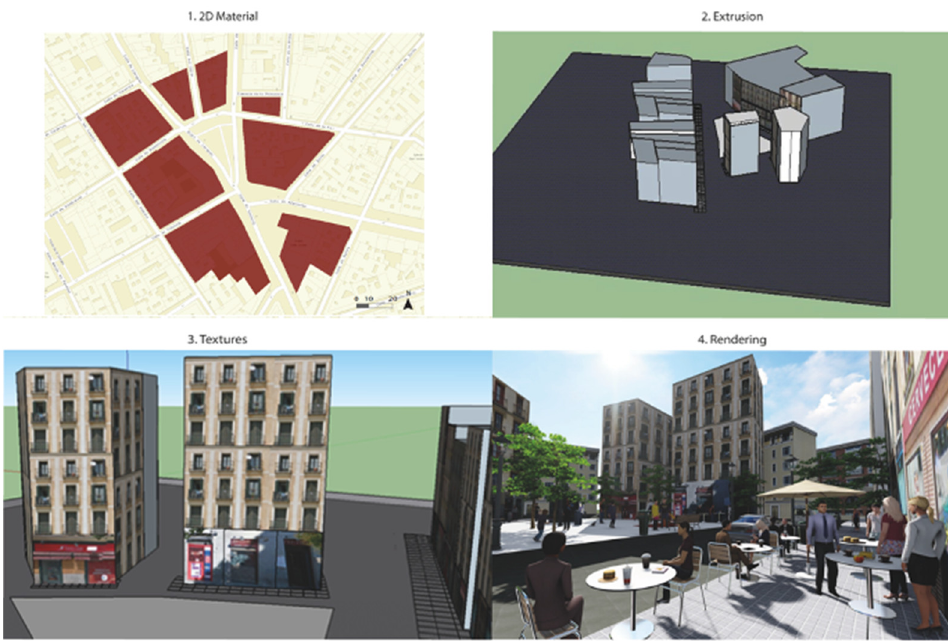
Figure 2. 3D modeling procedures (2D Material, Extrusion, Textures, and Rendering).